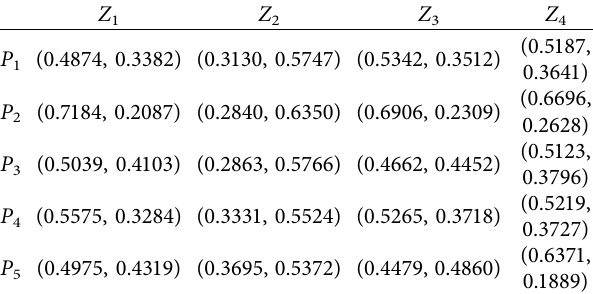
Table 6: Overall intuitionistic fuzzy